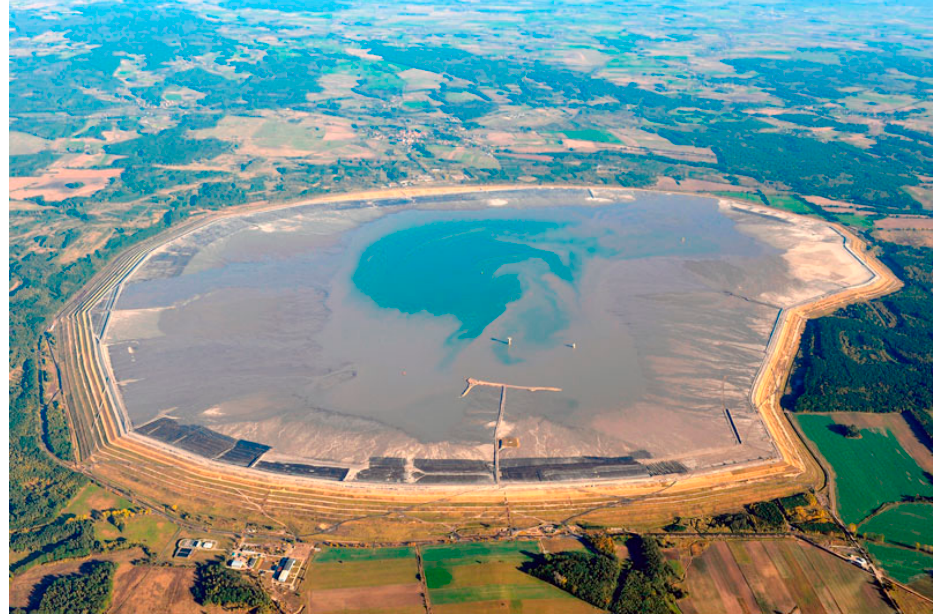
Figure 1. Topographic model of Ż elazny Most tailing pond.